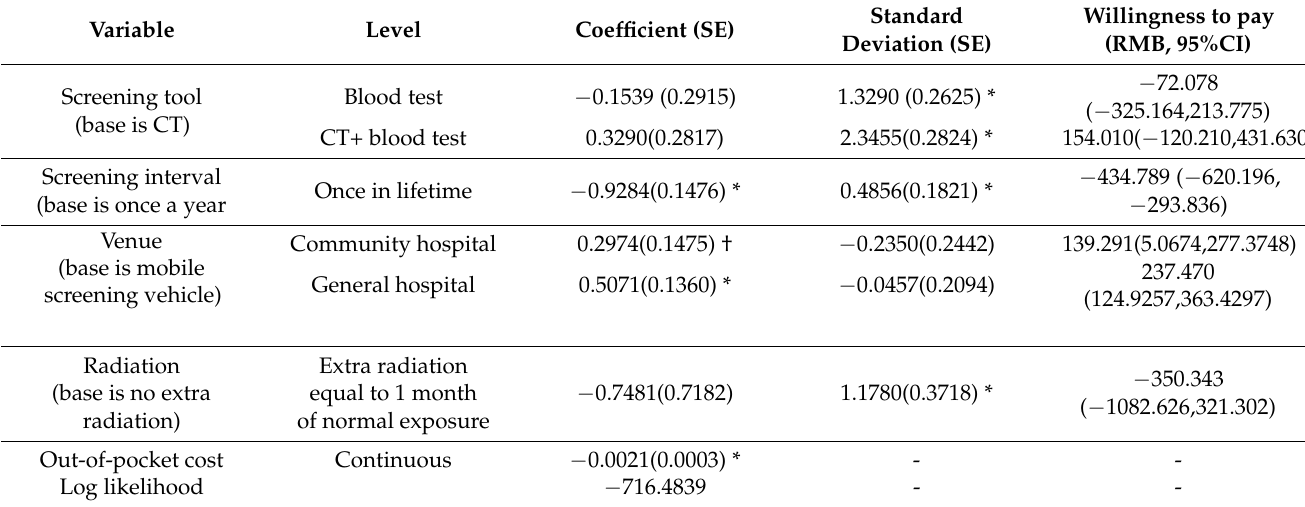
Table 3. Results of mixed logit analysis (all